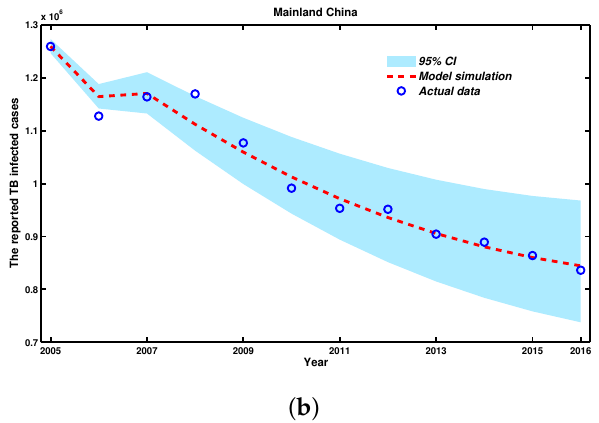
Figure 4. The fitting curve and observed data from 2005 to 2016 in Mainland China with Model (2). ( a ) The simulation result for the cumulative number of people infected with TB; ( b ) The simulation result for newly-infected TB cases, where the red dashed line is the simulated curve of Model (2), the light grey area is the 95% confidence interval (CI) for all 2000 simulations, and the blue circles are the reported TB infection cases.